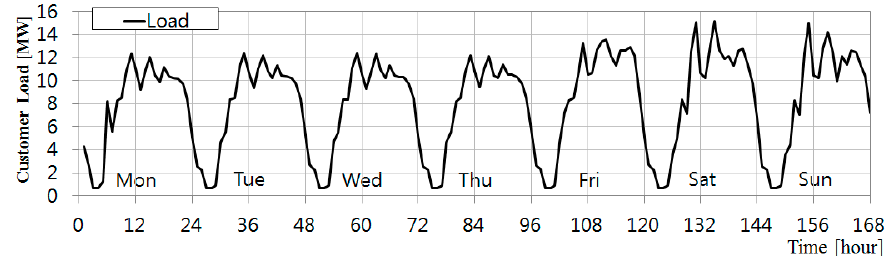
Figure 5. Customer’s energy rate (TOU) for a week.